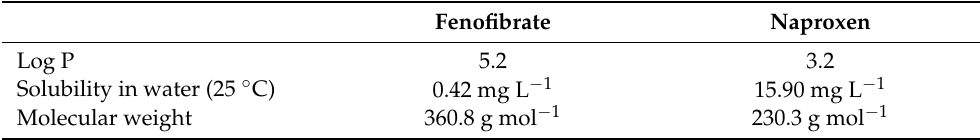
Table 1. General characteristics of fenofibrate and naproxen [23].